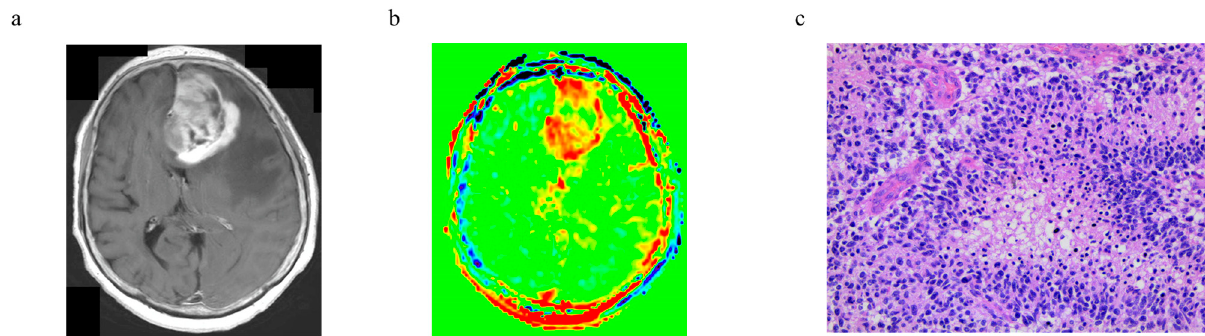
Figure 6. A representative case of glioblastoma, IDH-wildtype: ( a ) T1-weighted image with gado- linium, ( b ) APTw image, and ( c ) histology (H–E staining).